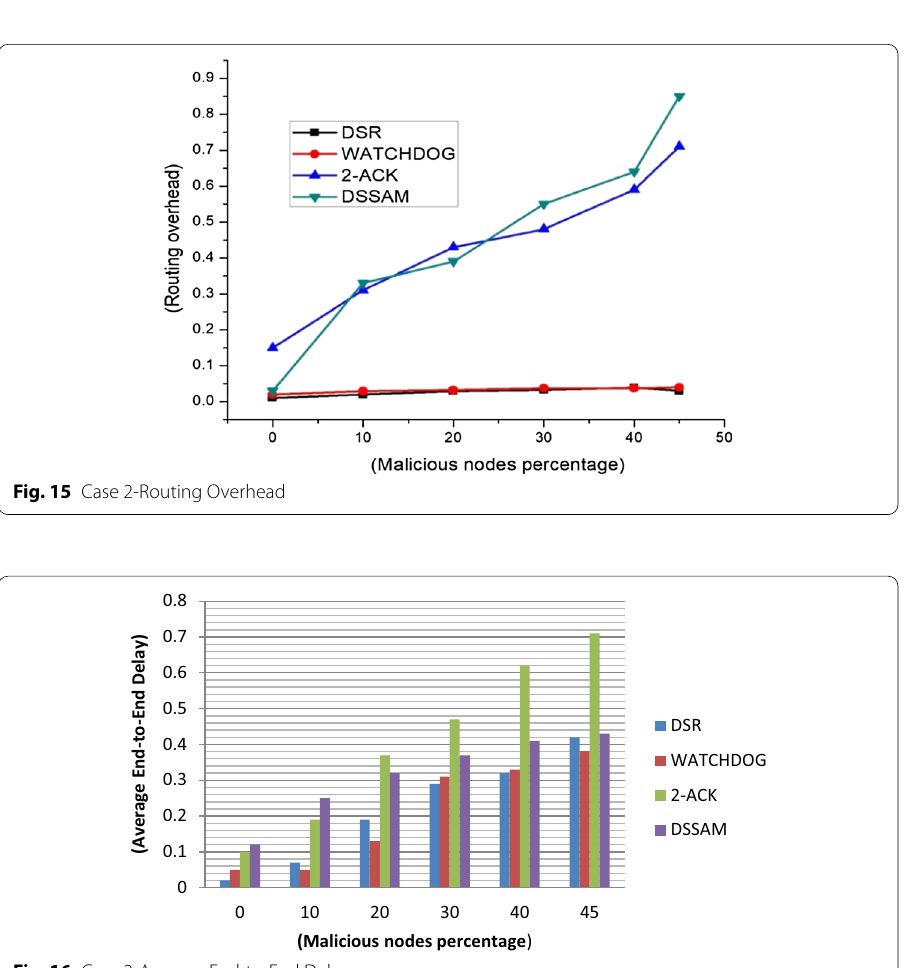
Fig. 16 Case 2-Average End-to-End